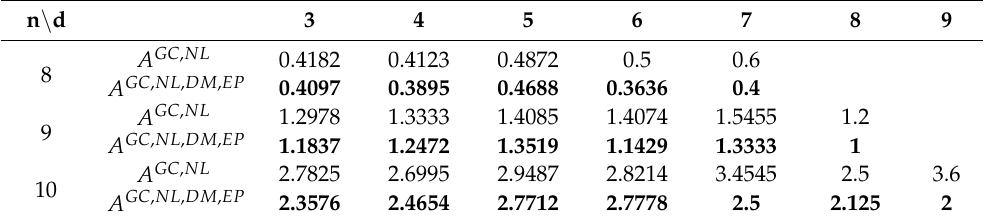
Table 14. Comparison results for the hairpin structure ratio, where the best results are bolded to